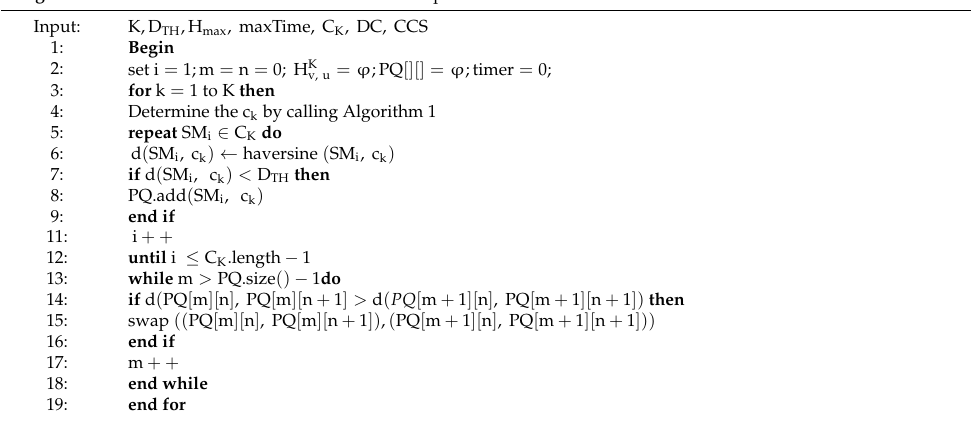
Algorithm 2 for dual-head selection and rotation for optimal route